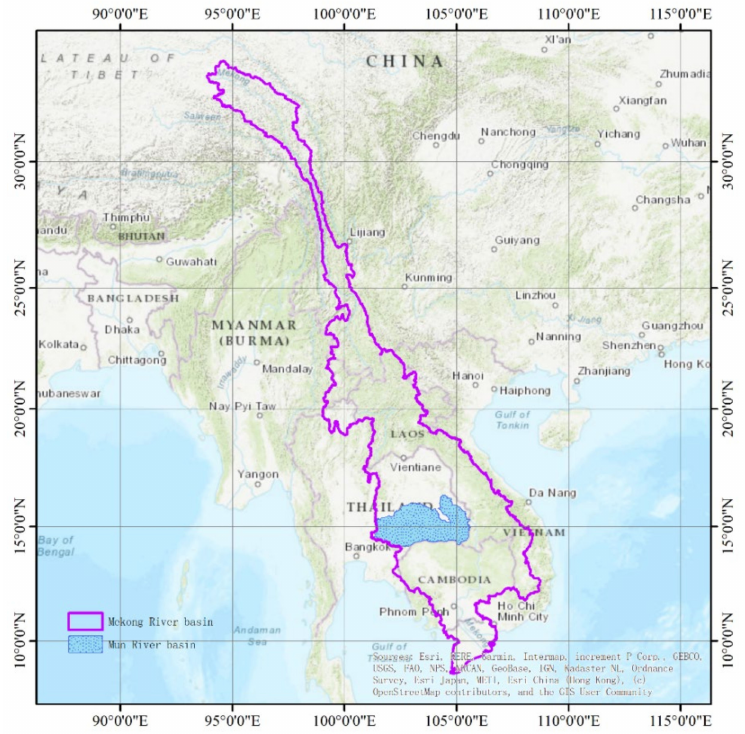
Figure 5. Location of the test site in